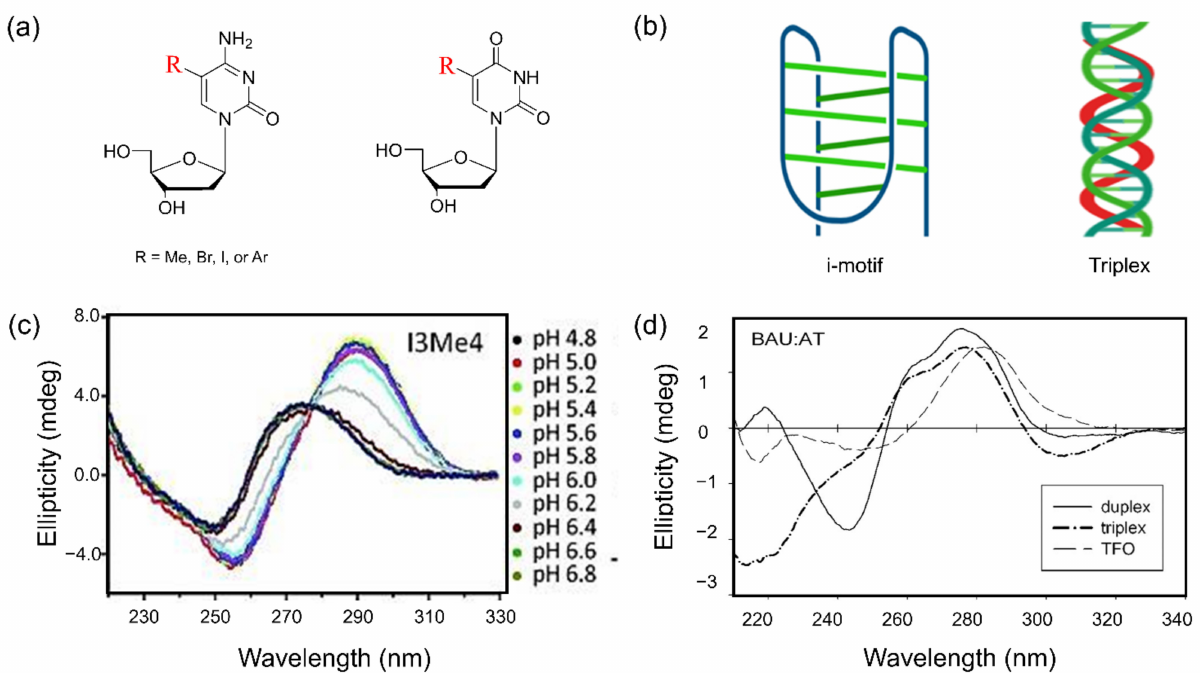
Figure 10. ( a ) Graphical representation of modified cytosine and uracil at the C5 position; ( b ) structures of i-motif and Triplex; ( c ) CD spectra of i-motif-containing modified cytosine at different pH indicated by different colors, from ref. [203]; ( d ) comparison of CD spectra between duplex (solid), triplex (dashed dot), and triplex-forming oligonucleotides (TFO, dashed) containing modified sequence at pH 6 from ref. [212]. Copyright (2015) John Wiley and Sons, Inc., and (2004) Oxford